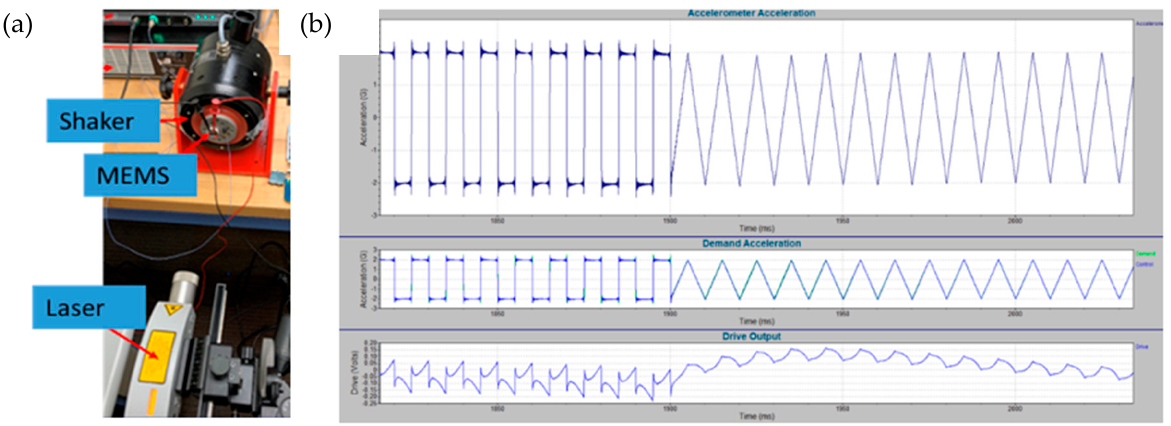
Figure 12. ( a ) The experimental set up to test the MEMS CTRNN, ( b ) samples of the triangle and square acceleration profiles generated by the mechanical shaker.